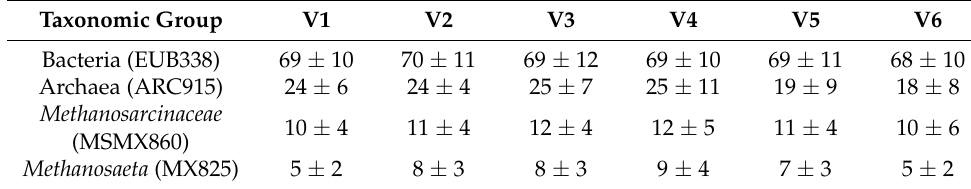
Figure 7. Biogas and methane production in particular technological variants. Table 4. Microbial taxonomy in particular experimental